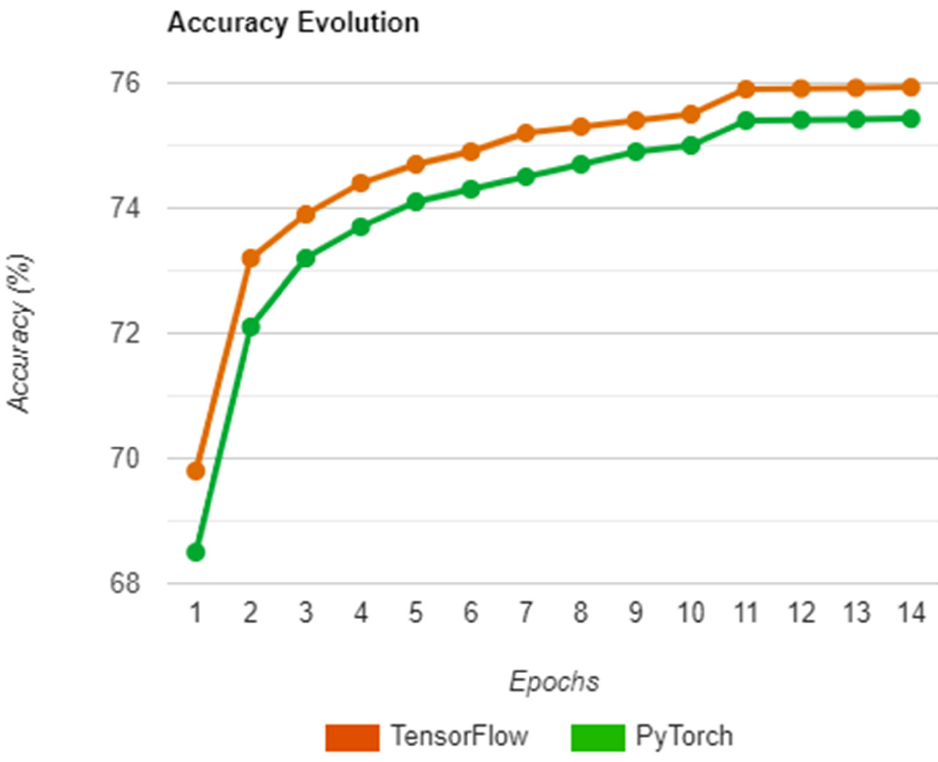
Figure 10. Accuracy evolution over the epochs.